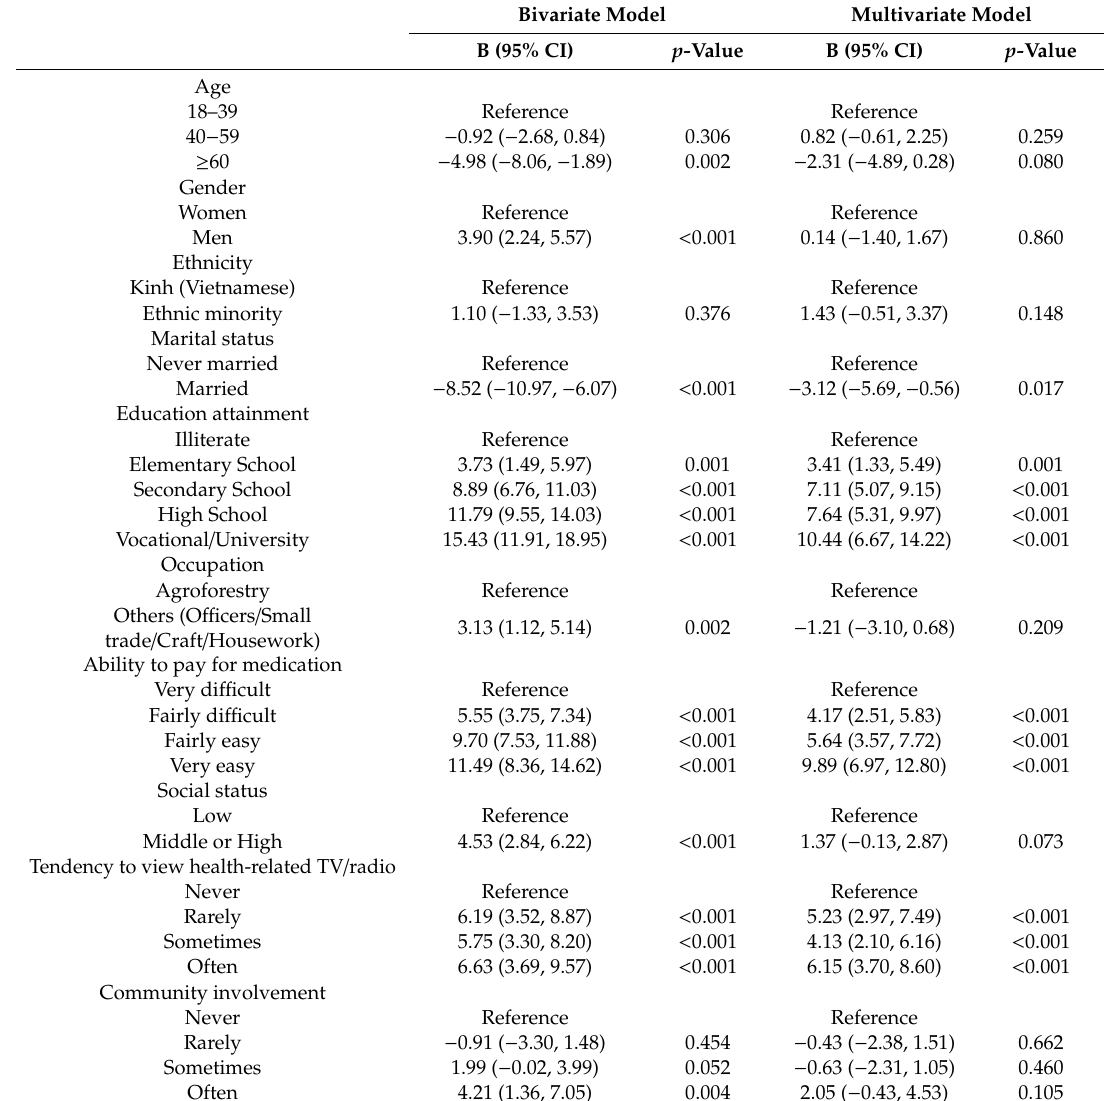
Table 3. Determinants of health literacy of people living in rural areas ( N =